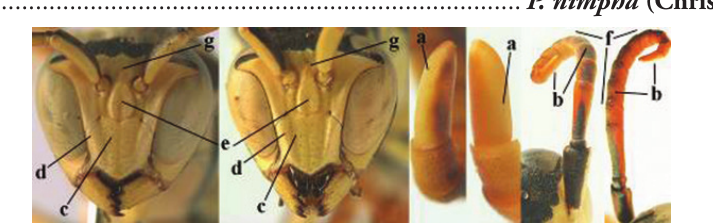
25 Dorsal length of apical antennal segment 2.2–2.9 times as long as its maxi- mal width (a), 1.3–1.5 times as long as fifth antennal segment (b); clypeus distinctly depressed medially (c) and with distinct lateral ridges (d); medio- longitudinal depression of face more or less impressed and U-shaped (e); antenna coloured according to fig. f; short carina between antennal sockets sharp dorsally and usually pale yellow (g); clypeus with short bristles and medio-ventrally flat; width of clypeus 1.0–1.1 times its length; [head some- times distinctly narrowed ventrally]; Europe and Palaearctic Asia .................. ............................................................................ P. nimpha (Christ,